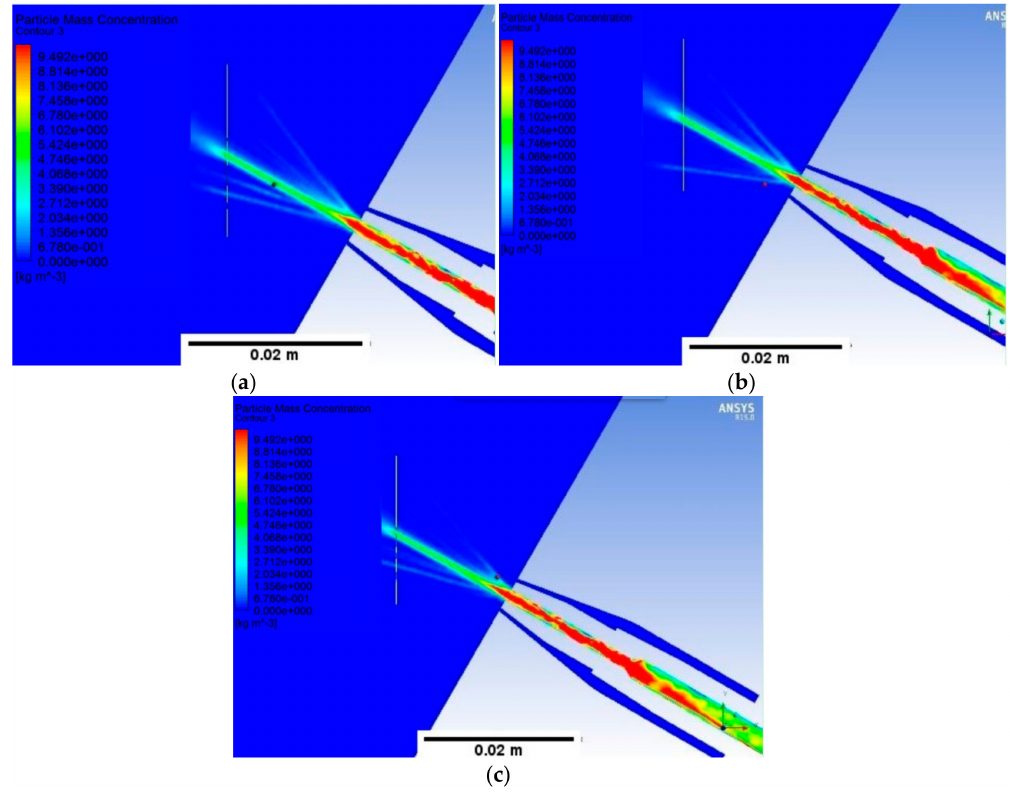
Figure 10. Carrier mass flow rate = 4.51e − 0.5 kg/s and powder feed rate = 0.1 g/s: ( a ) shielding mass flow = 0 kg/s; ( b ) shielding mass flow = 1.95e − 0.4 kg/s; ( c ) shielding mass flow = 2.92e − 0.4